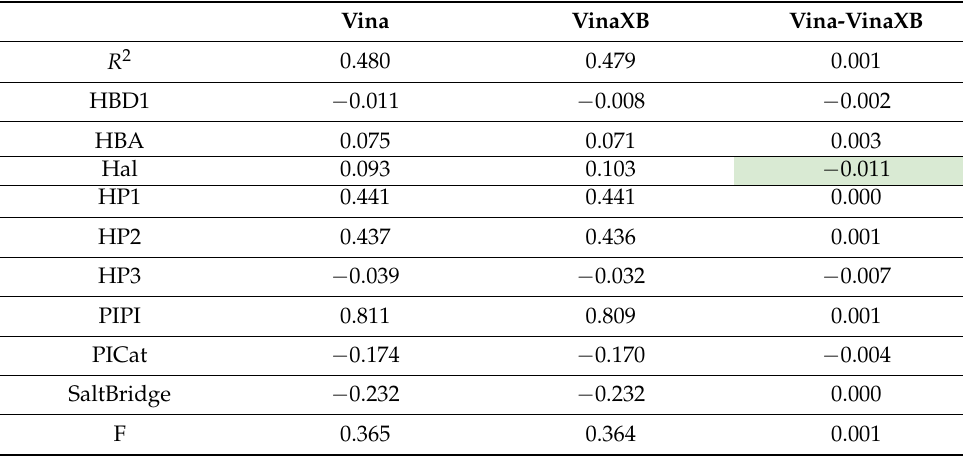
Table 6. Lasso regression coefficients for Vina and VinaXB at λ =